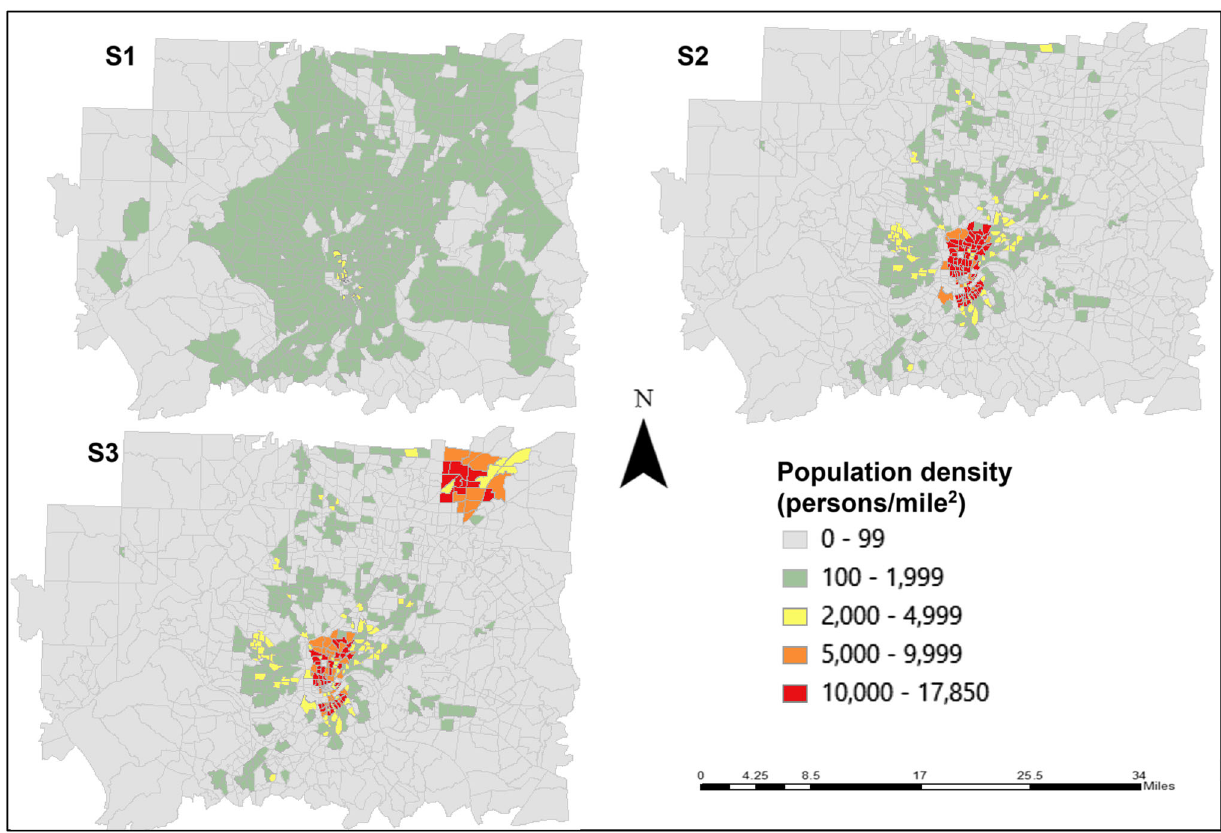
Fig. 5 Projected changes in population density compared with baseline data